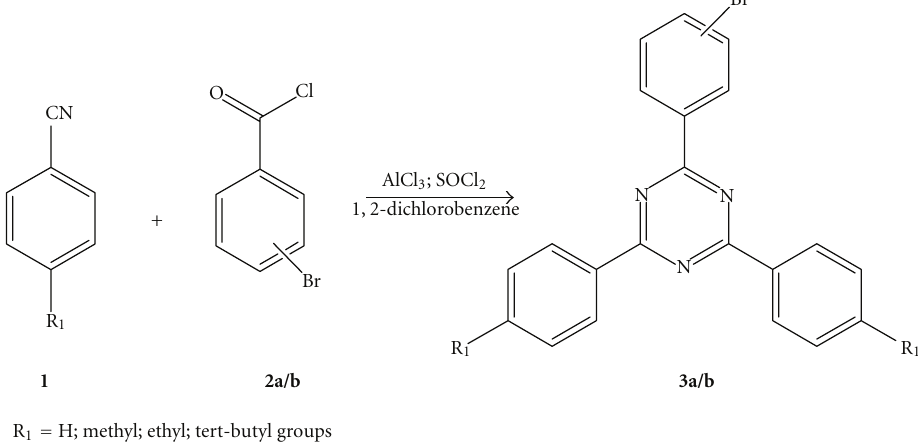
Figure 2: Nitrile route for building up the triazine core (a: 3-bromo-, b: